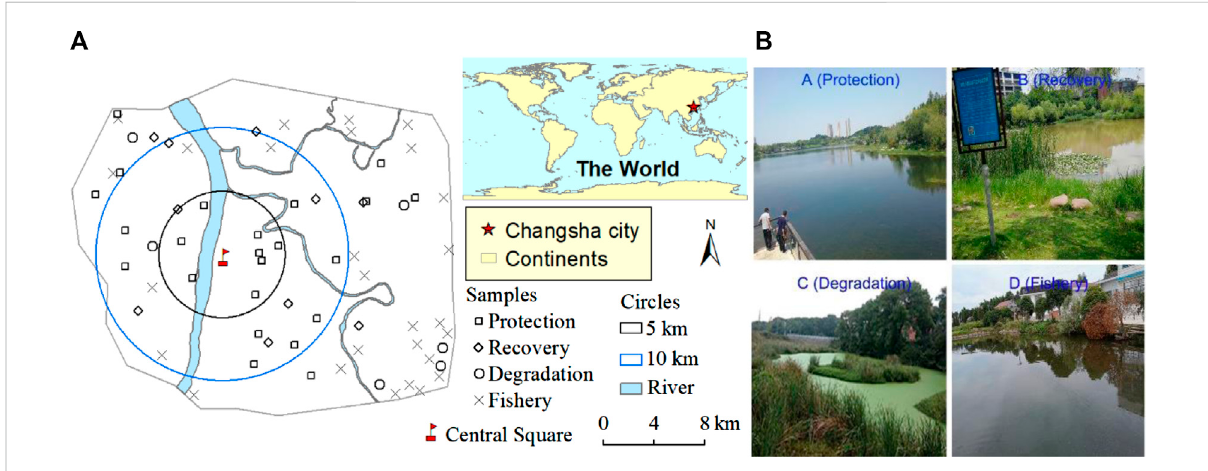
FIGURE 1 (A) The location of the study area, the spatial distribution of sampling sites for small water bodies and (B) the case diagram of the main management types for the small water